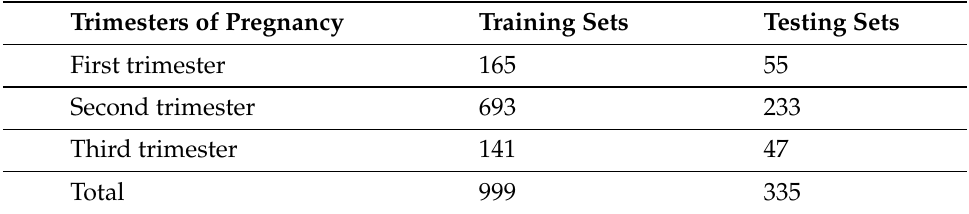
Table 1. Distribution of dataset during the various trimesters of